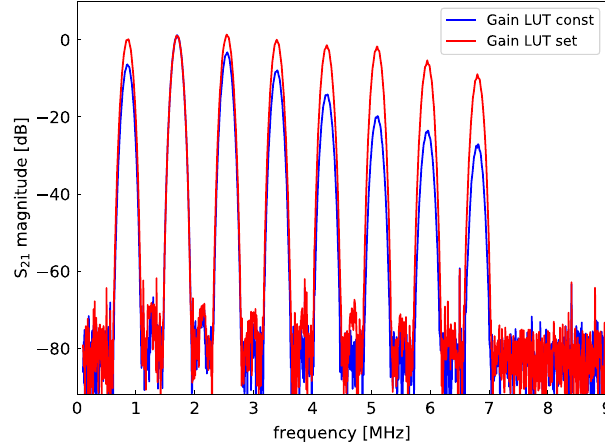
setting.FIG. 16. (Top) The measured I and Q at the 200 points and the interpolated ones and (bottom) the phase response calculated from the interpolated I and Q , when the phase offset LUT is set by using measured I and Q .